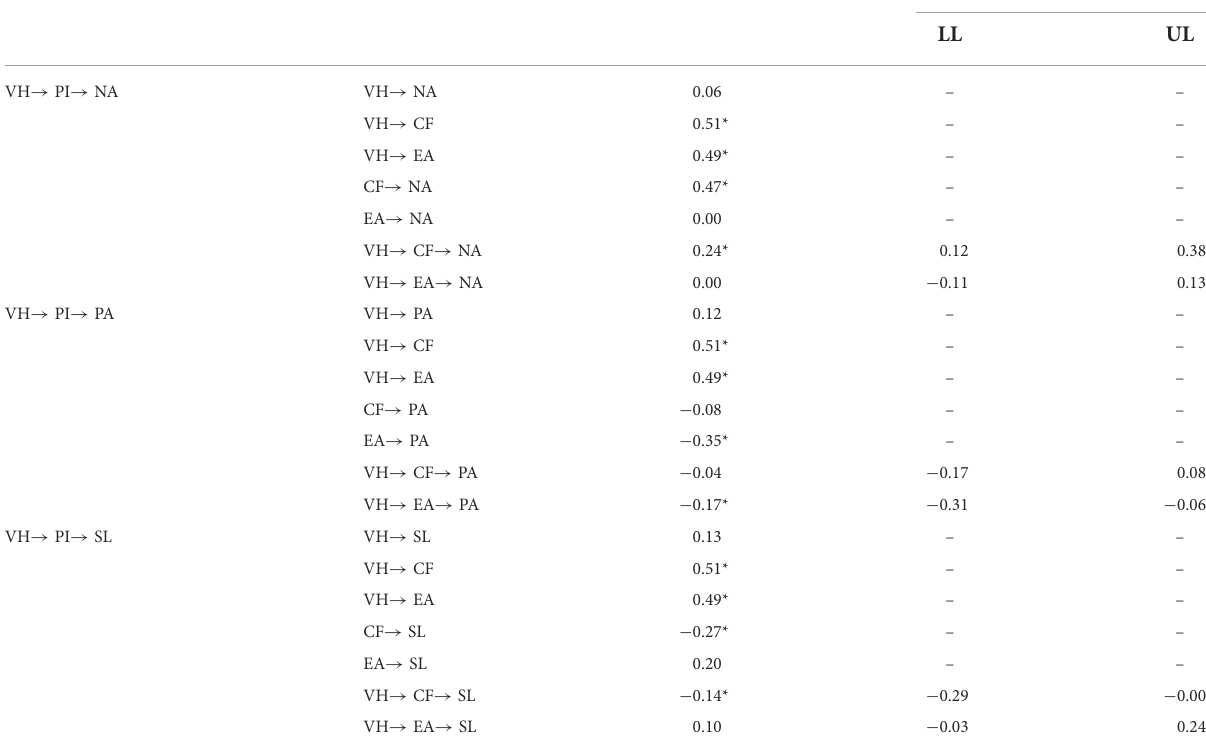
TABLE 2 Direct and indirect effects of mediational